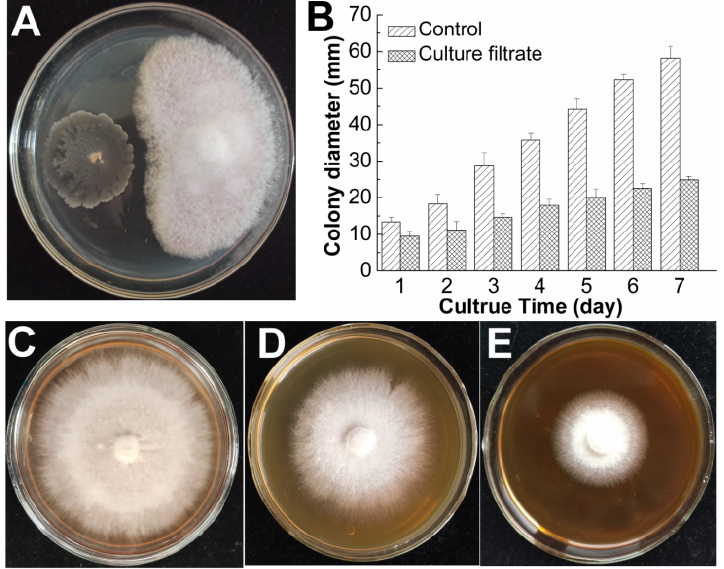
Figure 2. The antifungal activity of B. subtilis SF1 against F. foetens in vitro. ( A ) The confrontation assay of B. subtilis SF1 and F. foetens on PDA. ( B ) The colony diameter of F. foetens on PDA with and without B. subtilis SF1 culture filtrate. ( C – E ) The colony of F. foetens on PDA supplemented with different volumes of culture filtrate, the volume ratio of culture filtrate to water was 0:5, 2:3, and 5:0, respectively.